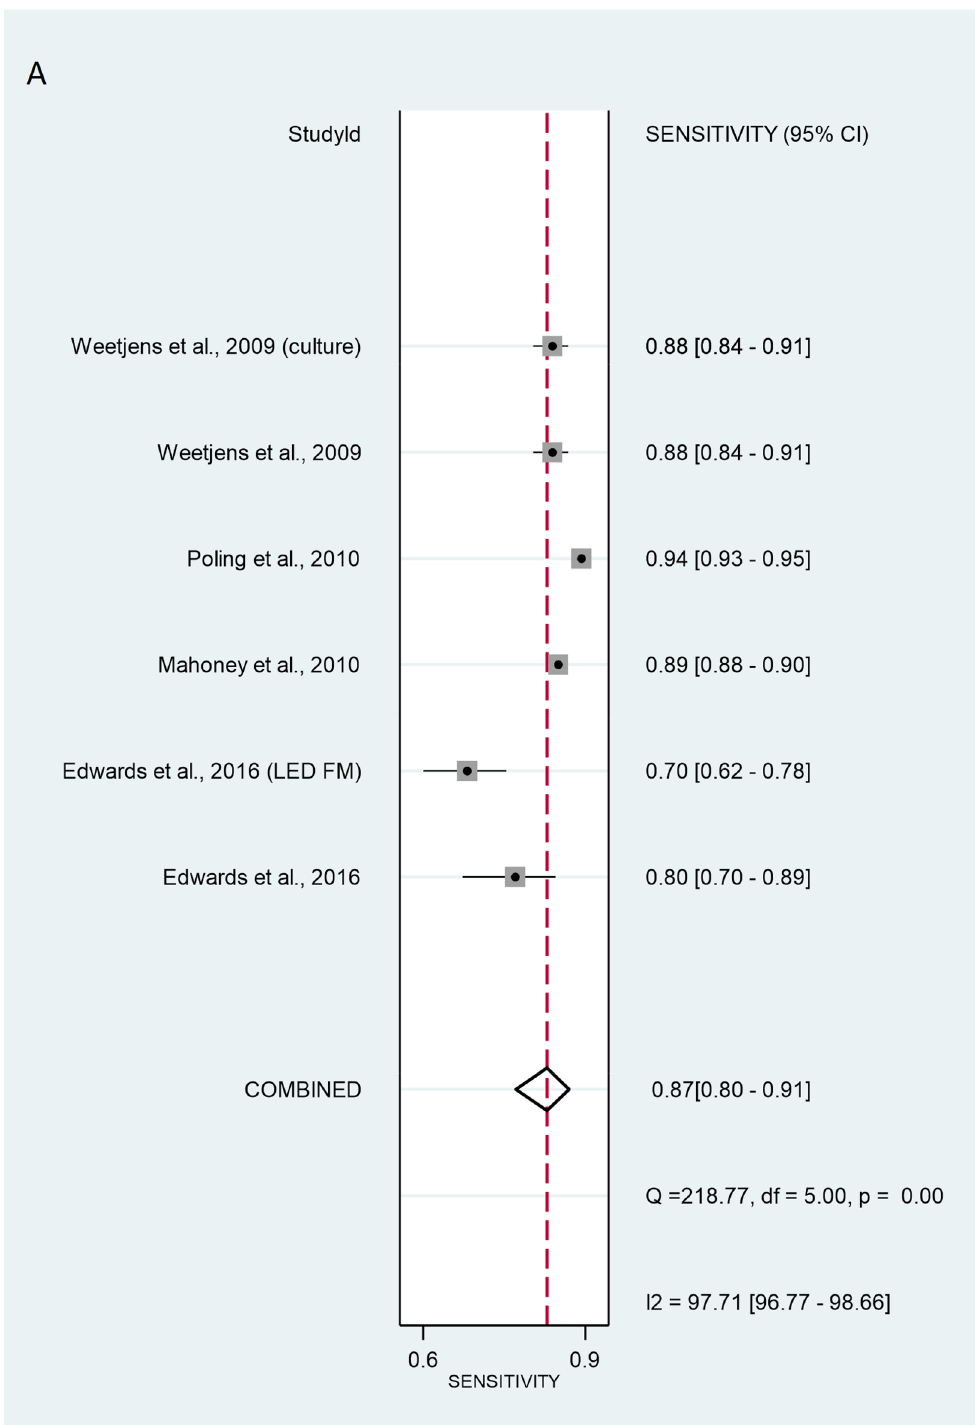
Figure 4. Sensitivity ( A ) and specificity ( B ) of individual studies are displayed by squares. The overall values are displayed by rhombus. Error bars indicate confidence interval of 95% [95% CI]. The reference method was Ziehl–Neelsen stain-based, direct microscopy, except for other method is indicated in